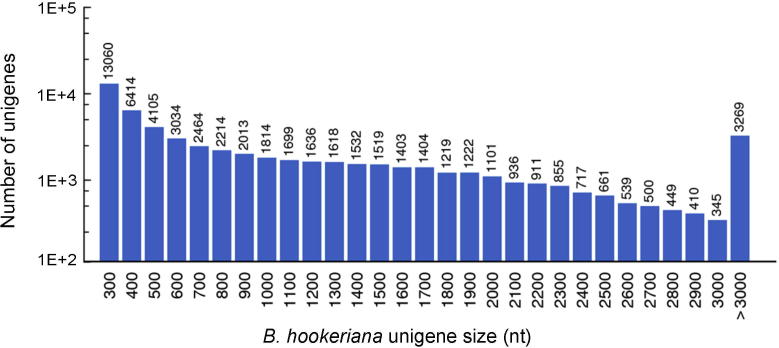
Length distribution of B. hookeriana unigenes